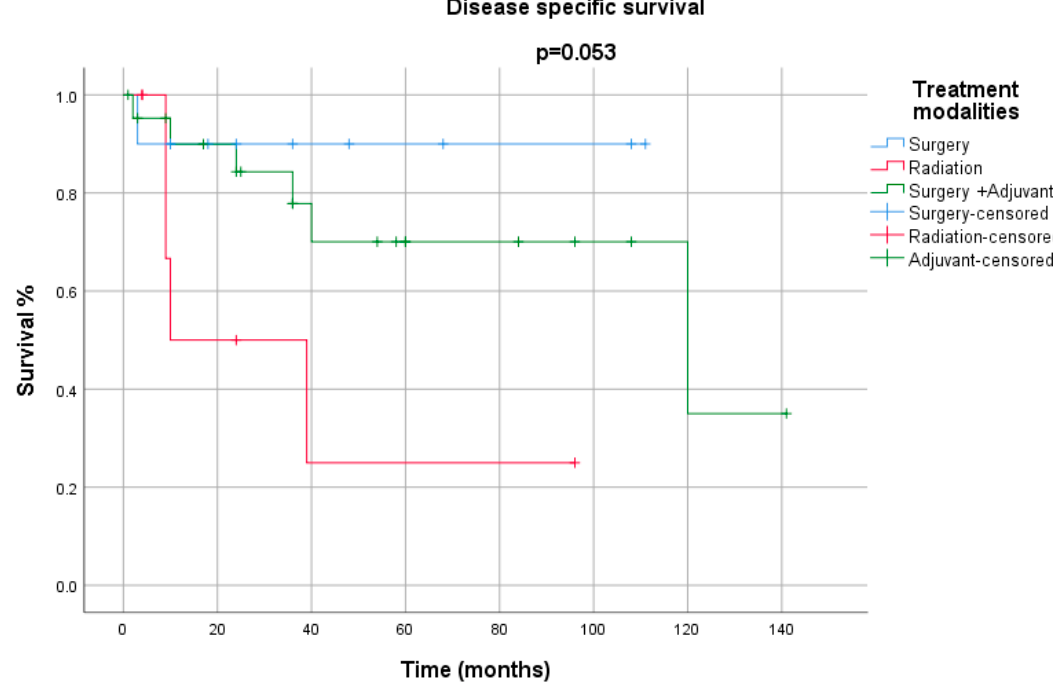
Figure 6. Disease-specific survival for treatment modalities.